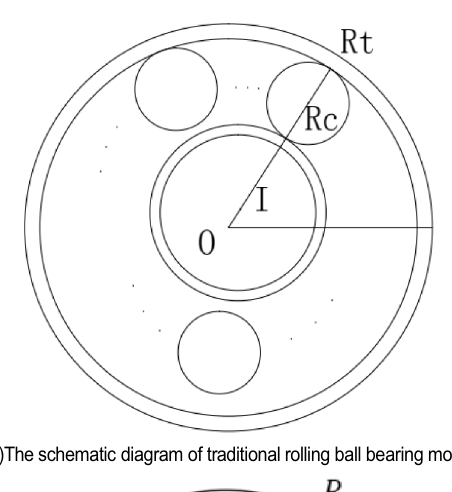
Fig. 2 The more general analytical diagram for the rolling ball bear- ing without the hypothesis that the three center points of the inner ring, the outer ring and the rolling ball are collinear, i.e. the points O, I, R c are not